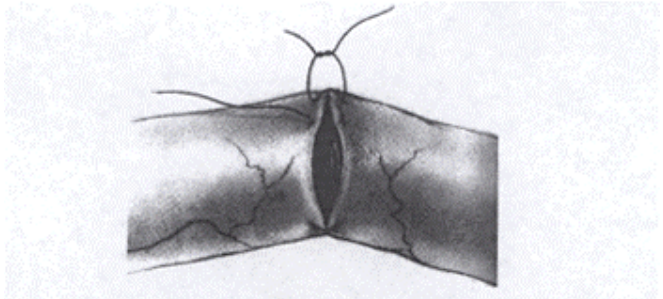
FIGURE 8 . The outer layer is completed with 8-0 sutures.